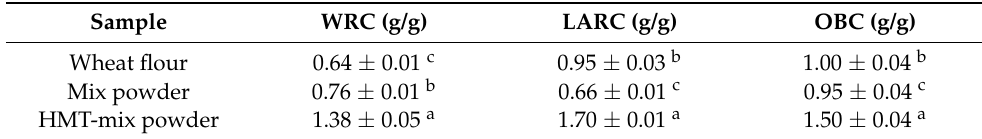
Table 2. Water retention (WRC), lactic acid retention (LARC) and oil binding capacities (OBC) of wheat flour, mix powder and HMT-mix